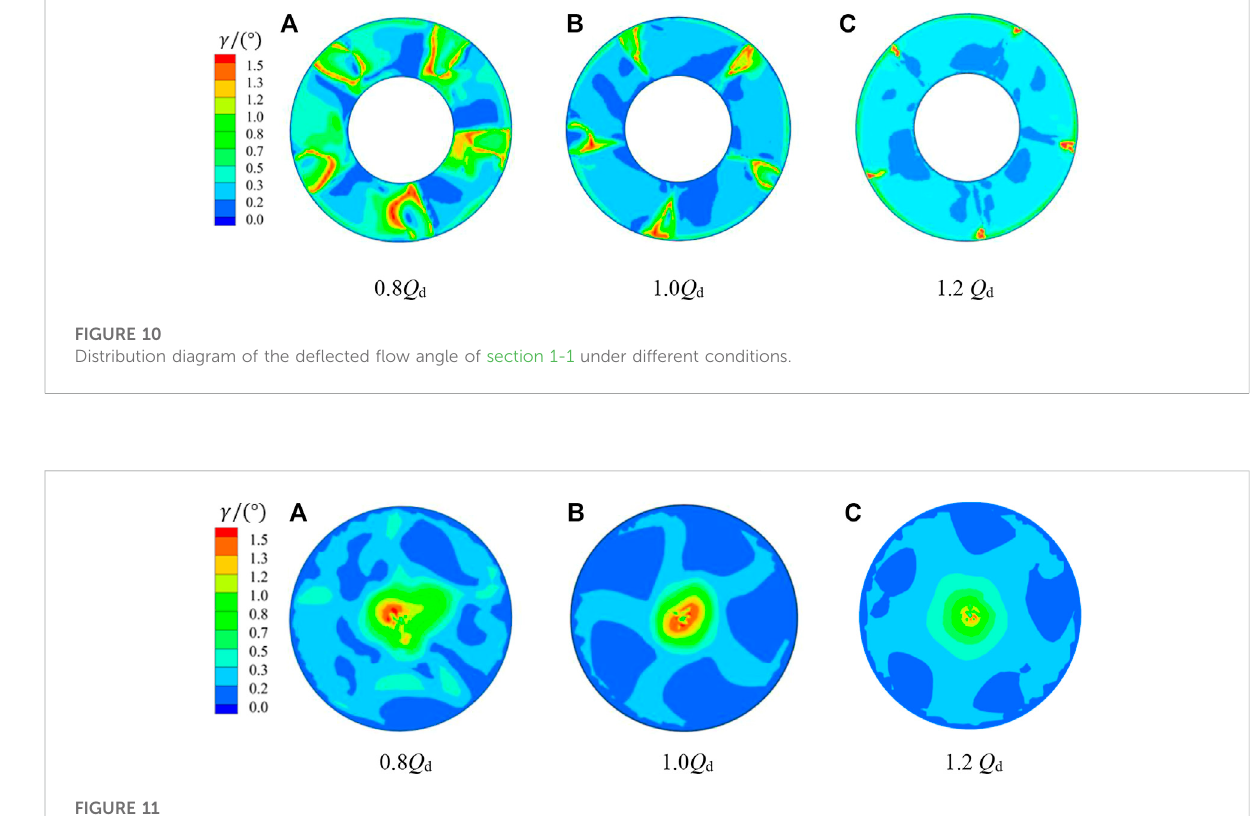
Distribution diagram of the de fl ected fl ow angle of section 2-2 under different